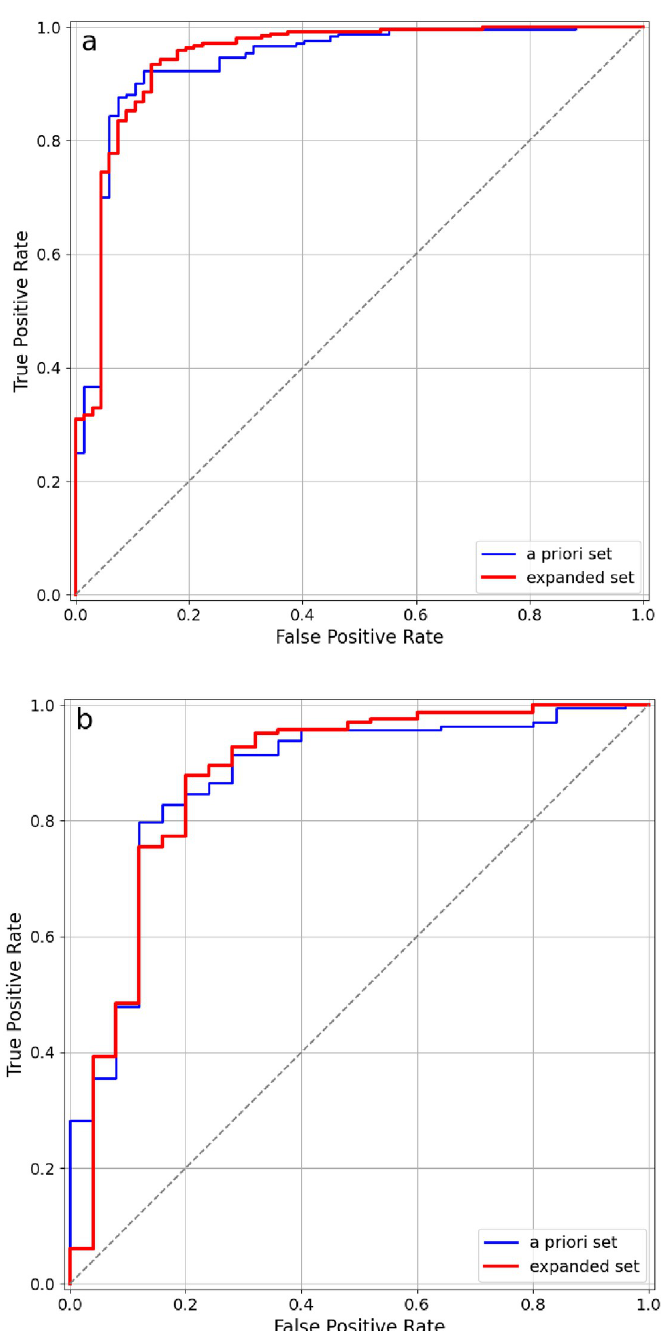
Fig 5. ROC curves for the proposed ML algorithm’s prediction that the patient is Anaphylactic (Ana) vs Sensitive (Sen). (a) patients with total IgE < 1000 kU/L, AUC 0.994; (b) patients with total IgE > 1000 kU/L, AUC 0.997 (AUCs are given for the expanded feature